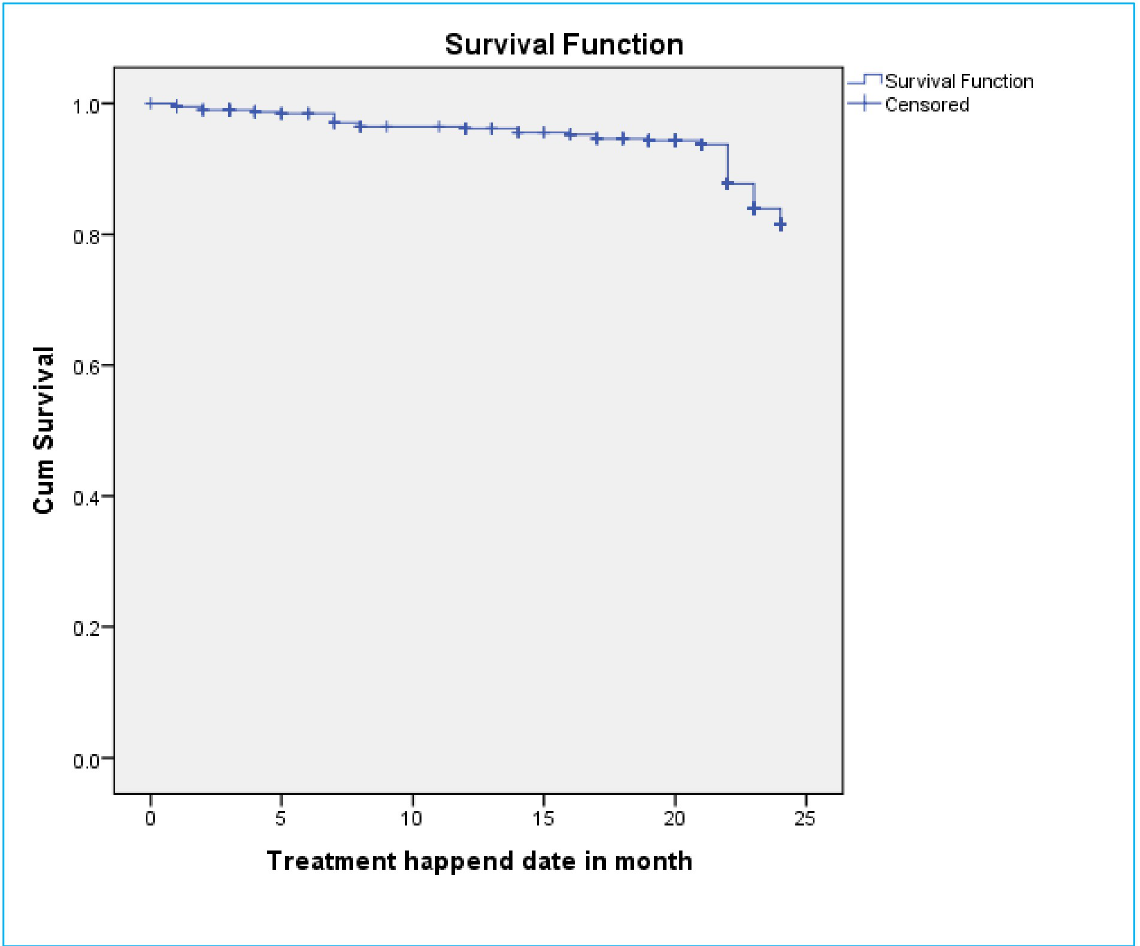
Fig 3. Kaplan–Meier survival estimate for loss to follow up of drug resistance tuberculosis infected patents in Oromia region, Ethiopia,